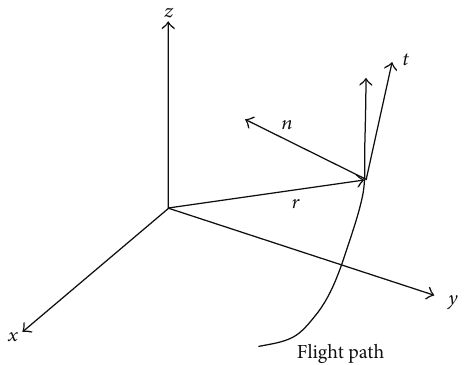
Figure 1: Orbit frame from position, tangential, and normal vectors.